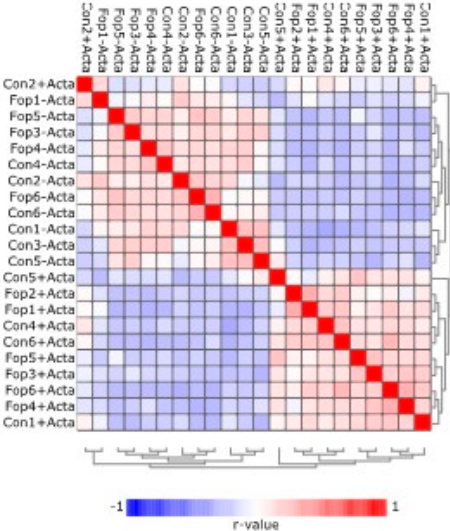
Figure 1. Samples cluster by experimental conditions. PCA plots and heatmap showing clustering of the samples. ( A ) PCA plot depicting inter-donor variability. − Activin-A and +Activin-A samples were grouped together per donor group. ( B ) PCA plot depicting inter-experimental variability. Control and FOP samples per experimental group (e.g., − Activin-A and +Activin-A) were grouped together. ( C ) Pearson’s correlation heatmap showing the grouping of samples with similar experimental con- ditions. Both the non-supervised principal component analysis and the Pearson’s correlation showed that samples with the same experimental treatment clustered together, indicating that the variation induced by the treatment was larger than the variation induced by the different donors (control n = 11 in total (without and with Activin-A); FOP n = 11 in total (without and with Activin-A)).